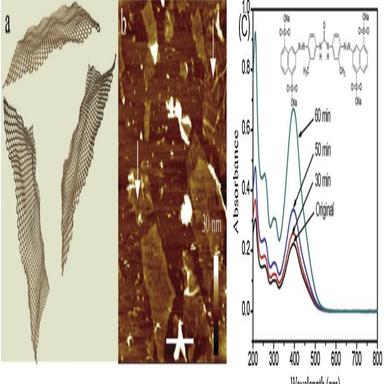
(a) Diagram of graphene sheets in liquida showing possible corrugation; (b) Chemically converted graphene (CCG) sheets imaged by tapping mode AFM in water; scale bar: 250 nm. The arrows highlight the most corrugated sheets. (c) UV–vis absorbance spectra of DY aqueous solutions showing the higest rejection by the 90 °C reduced membrane, increasing the concentration of the top liquid as the time passes.